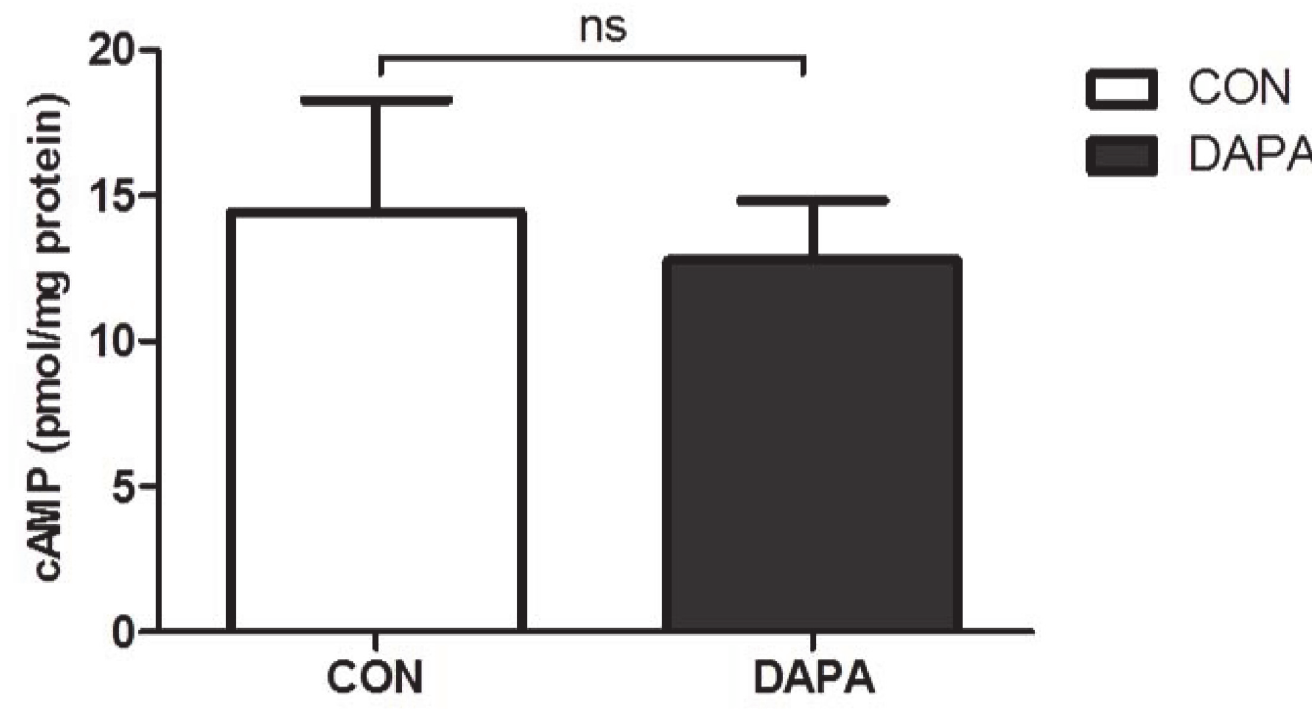
Fig 6. Effect of DAPA on renal cAMP content. Analysis of cAMP concentration per mg protein in PCK rat kidneys treated with vehicle (CON) or dapagliflozin (DAPA). N = 8 per group. Columns represent means ± SE. ns = non-significant.